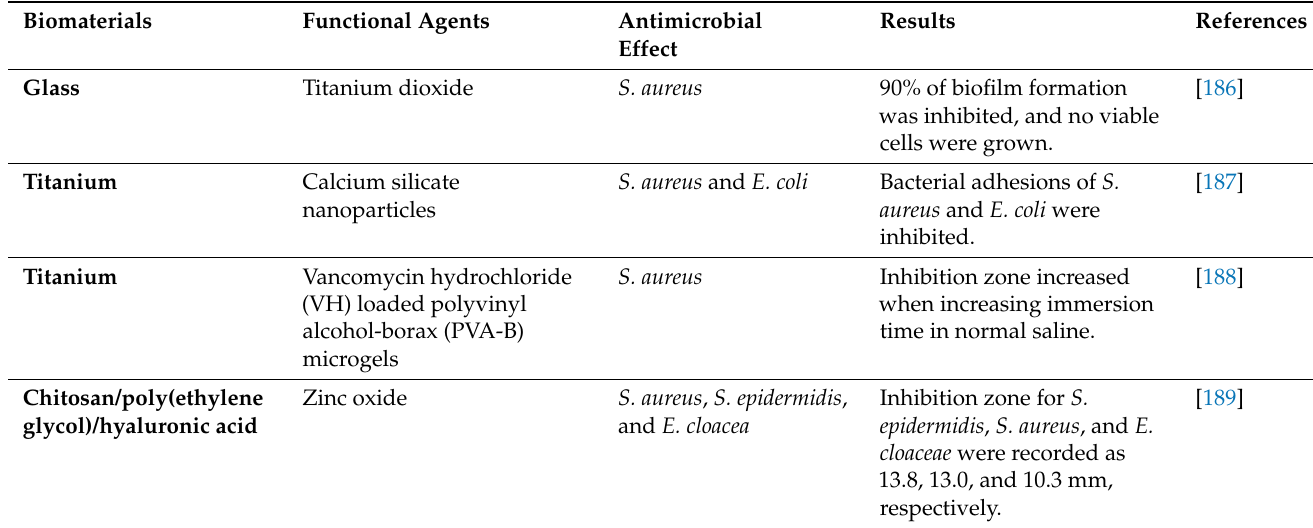
Table 11. List of some of the functional agents deposited on biomaterial via electrospray deposition method. Biomaterials